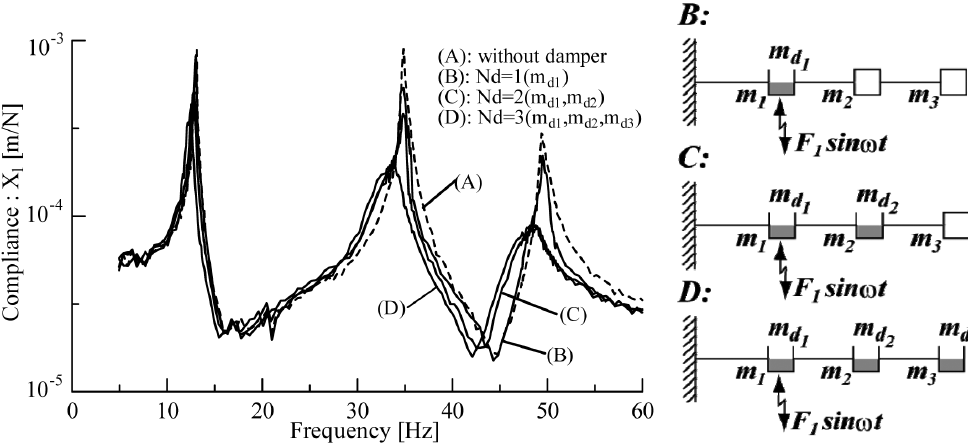
Fig. 8. Measured vibration of frequency response with number of damper unit N d . ( µ dj = 10% , d j = ∞ ; j = 1 , 2 , 3 : F 1 = 2 . 6[ N ]) .